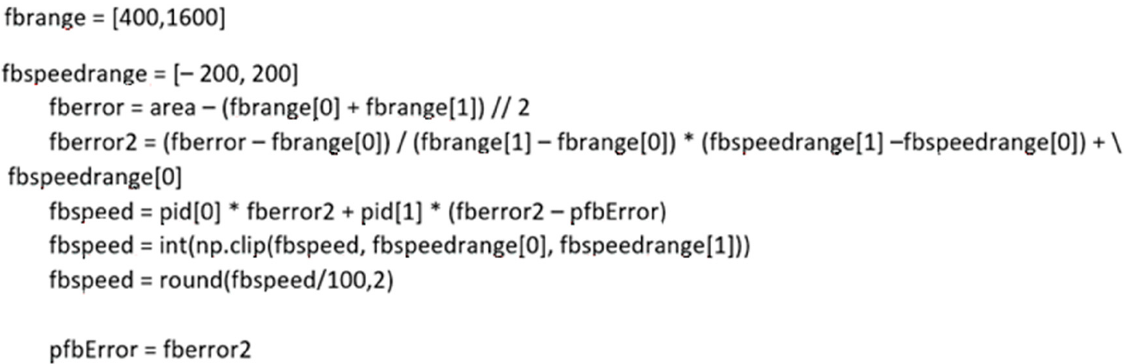
Figure 7. Programmatic implementation of the control algorithm.